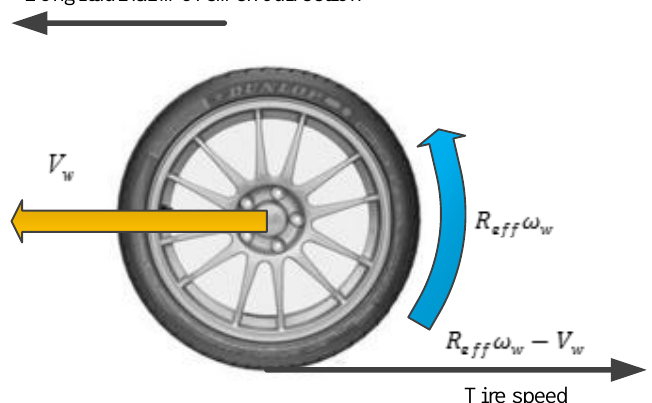
Figure 4. Tire longitudinal force diagram.